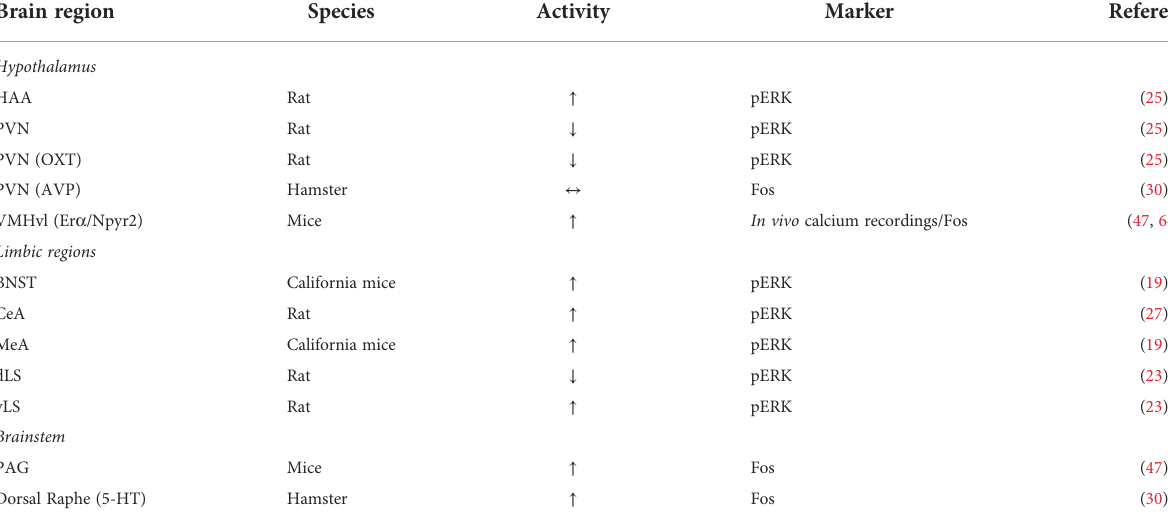
The table highlights the species and neural activity marker/method used. HAA, Hypothalamic attack-area; PVN, paraventricular nucleus of the hypothalamus; OXT, oxytocin; AVP, vasopressin; VMHvl, ventromedial hypothalamus ventrolateral part; Er a , Estrogen receptor alpha; Npyr2, Neuropeptide Y receptor 2; BNST, bed nucleus of stria terminalis; CeA, Central amygdala; MeA, medial amygdala; dLS, dorsal lateral septum; vLS, ventral lateral septum; PAG, periaqueductal gray matter; 5-HT, serotonin; ↑ , increased activity; ↓ , decreased activity; ↔